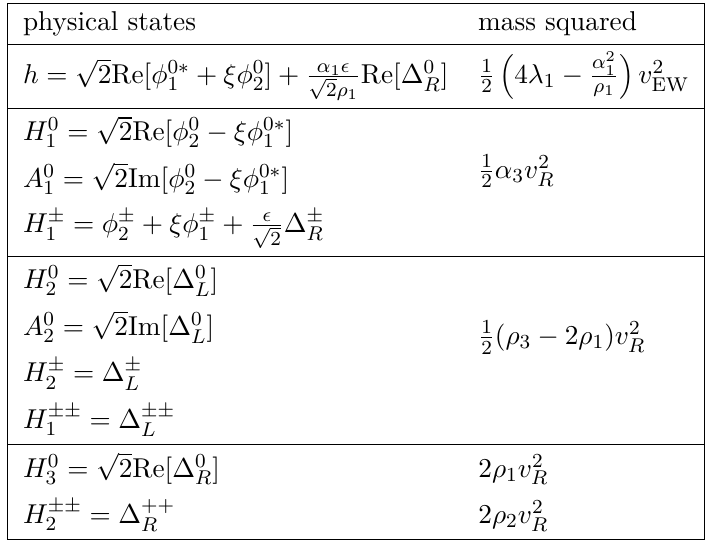
, W ± } , the self-energy L R